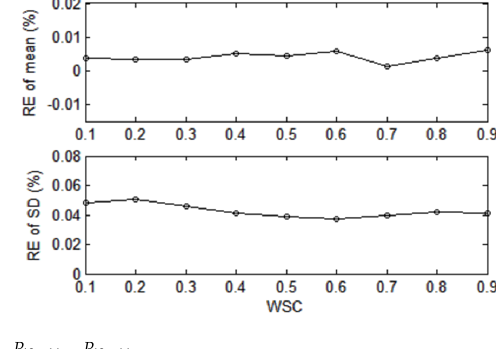
Figure 8. ε P 13 ´ 14 µ , ε P 13 ´ 14 σ of 3-order SG-PLF method under different WSC.